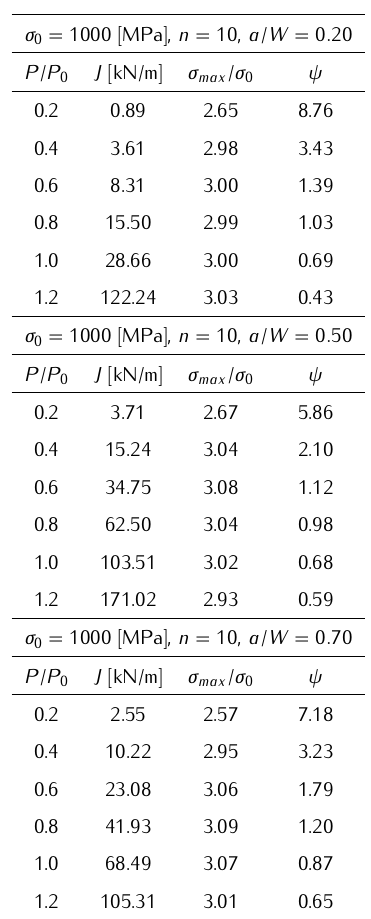
Table C4. NumericalresultsforCC(T)specimenscharacterized by yield stress σ MPa and work hardening 0 = 1000 exponent in R-O relationship